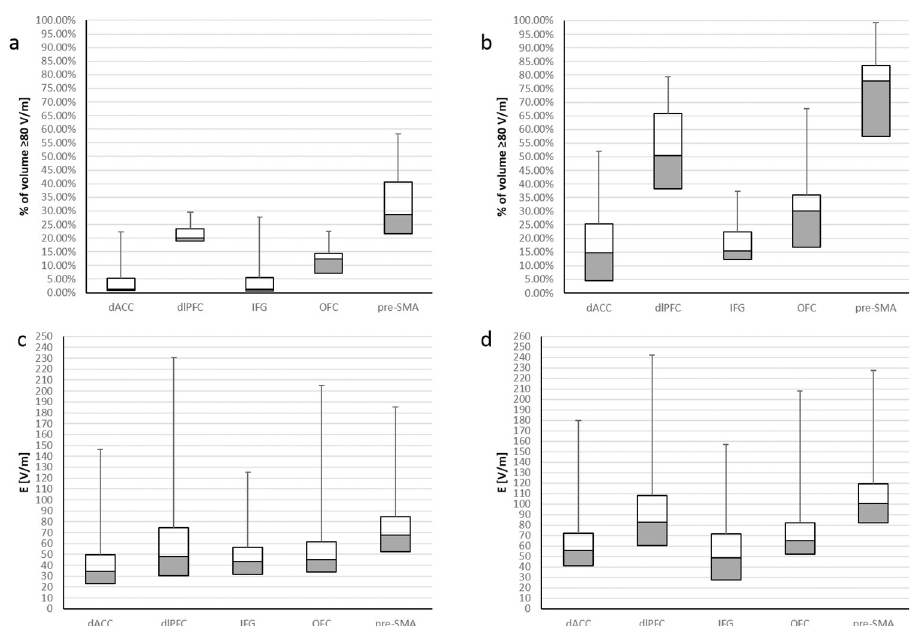
Fig 7. Descriptive statistics within specific brain regions. Descriptive statistics across 22 head models for five brain regions (dACC, dlPFC, IFG, OFC and pre–SMA) of the percentage of EF � 80 V/m for the D–B80 (a) and the H7 (b), and of the EF amplitude distribution within these regions for the D–B80 (c) and the H7 (d). dACC: dorsal anterior cingulate cortex; dlPFC: dorsolateral prefrontal cortex; IFG: inferior frontal gyrus; OFC: orbitofrontal cortex; pre– SMA: pre–supplementary motor